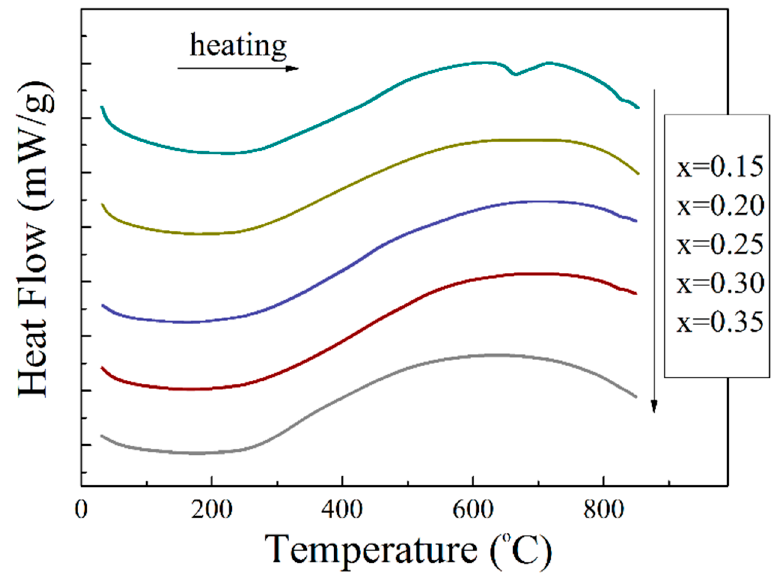
Figure 5. The dependency of heat transfer curves (DSC) obtained for the compounds with 0.15 ≤ x ≤ 0.35.